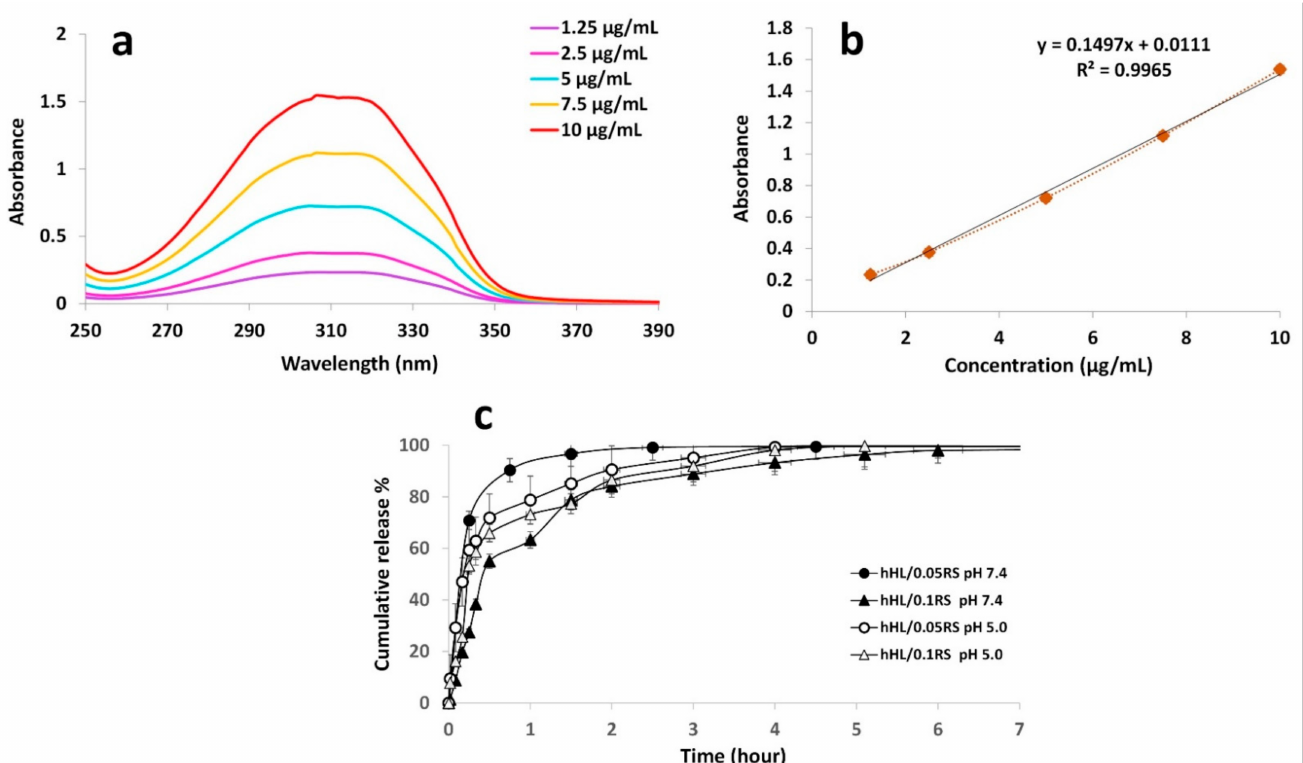
Figure 5. ( a ) UV absorbance spectra of RS and ( b ) calibration curve of RS at 309 nm, and ( c ) in vitro release studies of RS from nanoparticles at pH 7.4 and pH 5.0.